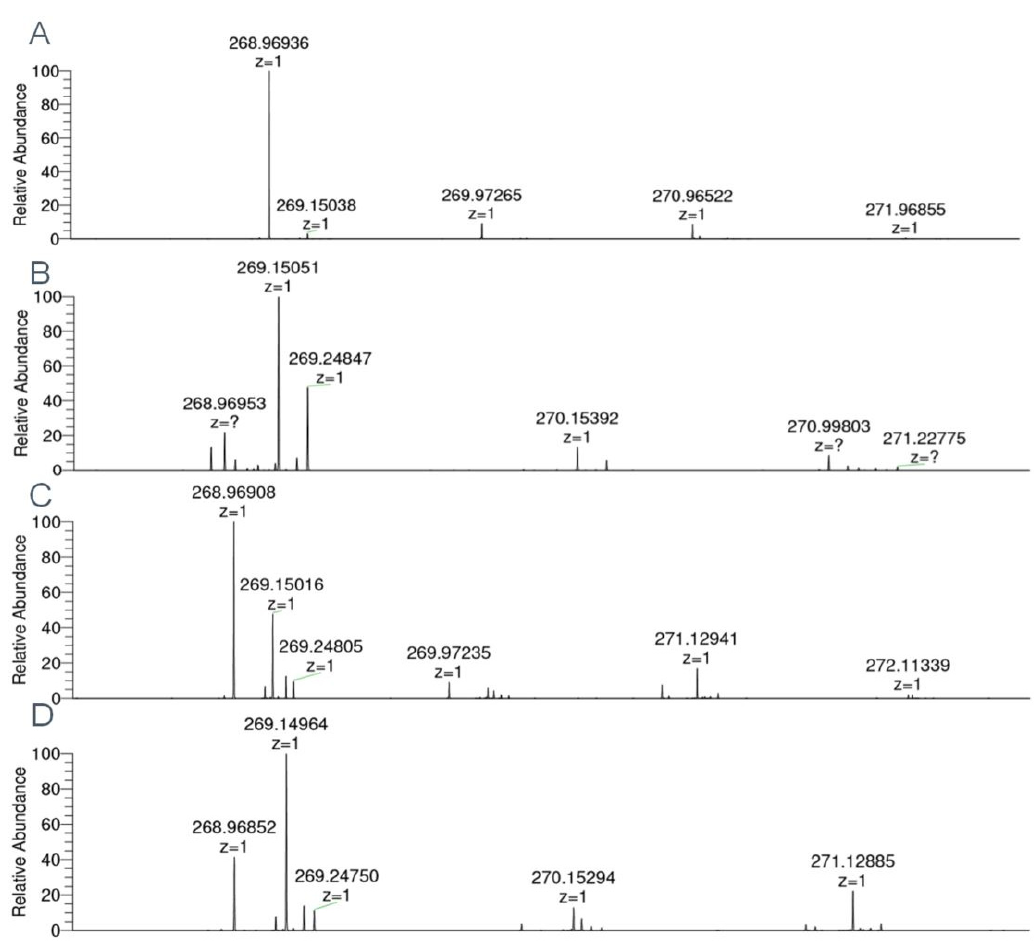
Figure 5. Mass spectra of 6-hydroxy-4-methyl-1,3-benzothiazole-2-carbonitrile sulfate (sulfated GSA) obtained by enzyme bag-catalyzed biotransformations with four human SULTs recombinantly expressed in fission yeast. ( A ) SULT1E1 (C 9 H 6 N 2 O 4 S 2 , [M–H] − theor. = 268.96962, [M–H] − exp.